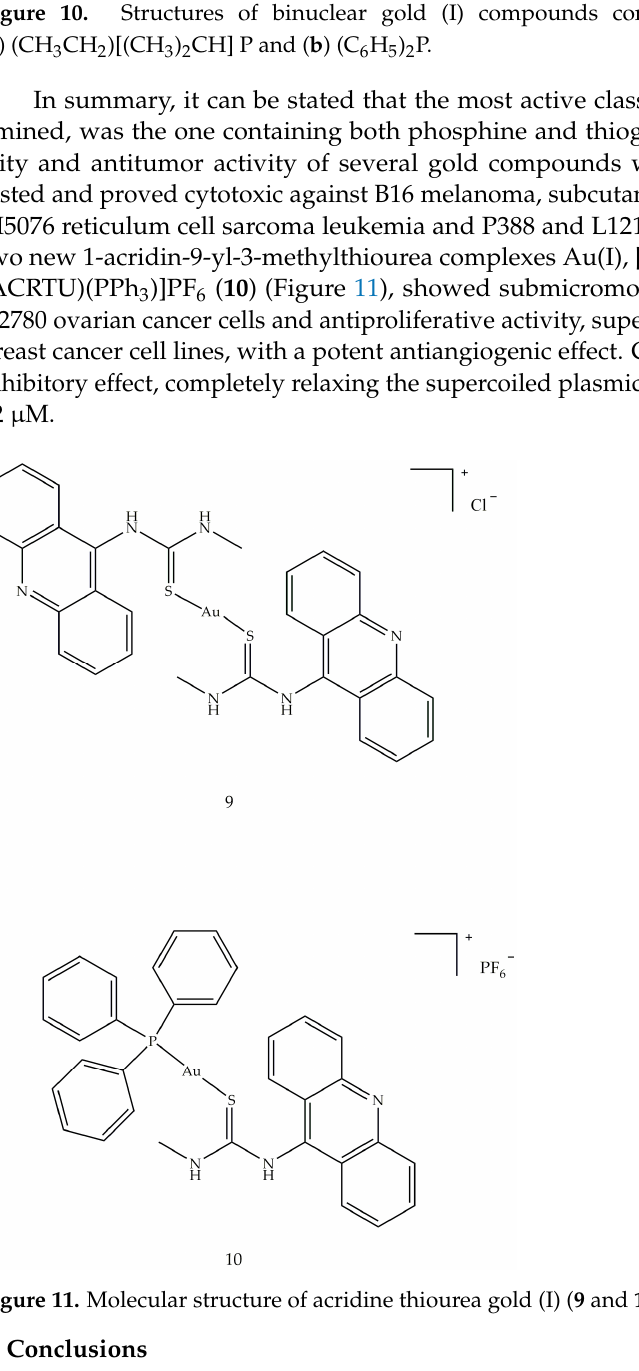
Figure 10. Structures of binuclear gold (I) compounds containing bidentate phosphines ( a ) (CH 3 CH 2 )[(CH 3 ) 2 CH] P and ( b ) (C 6 H 5 ) 2 P.